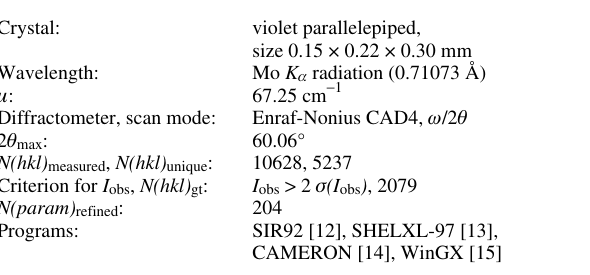
Table 1. Data collection and